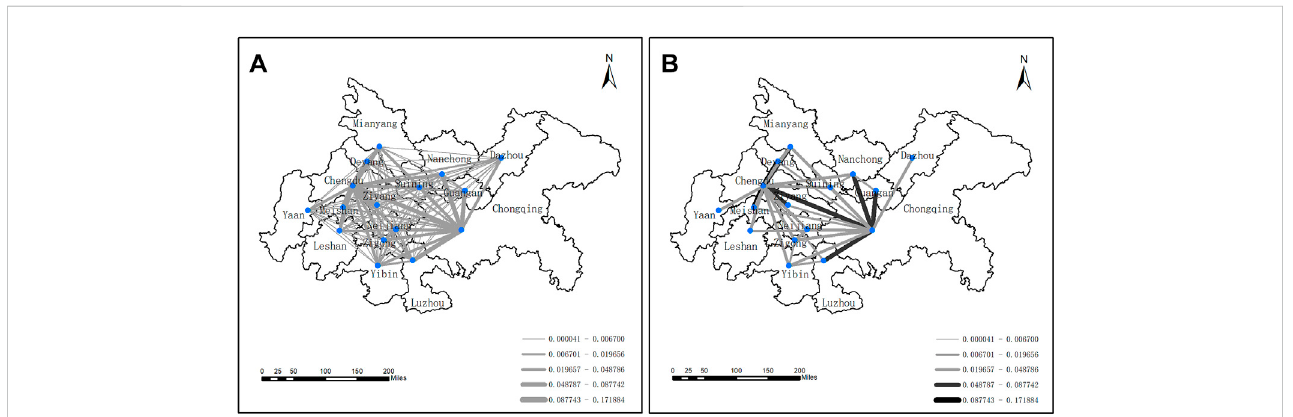
FIGURE 1 Economic linkage intensity of cities in Chengdu-Chongqing city cluster in 2020 (A,B) .